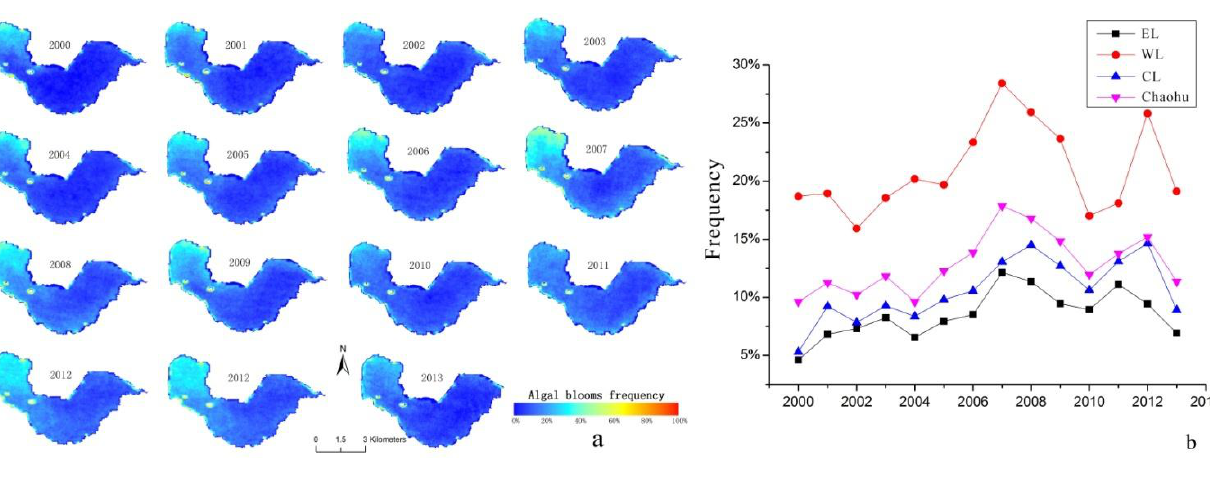
Figure 5. ( a ) Annual surface bloom frequency of Lake Chaohu from 2000 to 2013. ( b ) Annual average frequency of floating algae blooms in each lake segment of Lake Chaohu, including West Lake (WL), Central Lake (CL), and East Lake (EL), when algal bloom coverage > 0, using the algal bloom pixel growing algorithm (APA) and MODIS images.